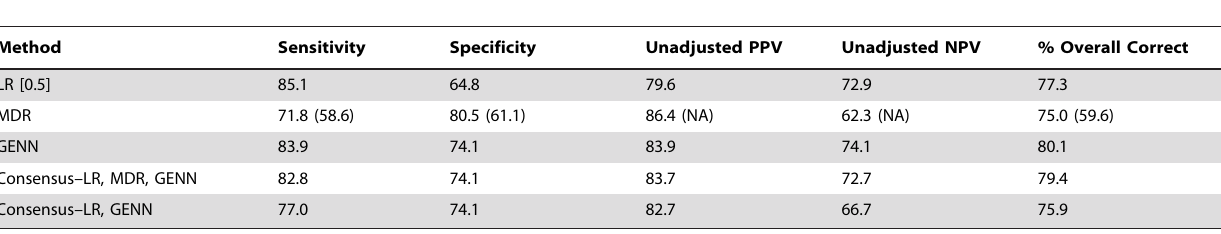
Table 4. Classification rates using the VM training dataset for training and VM testing dataset for testing.